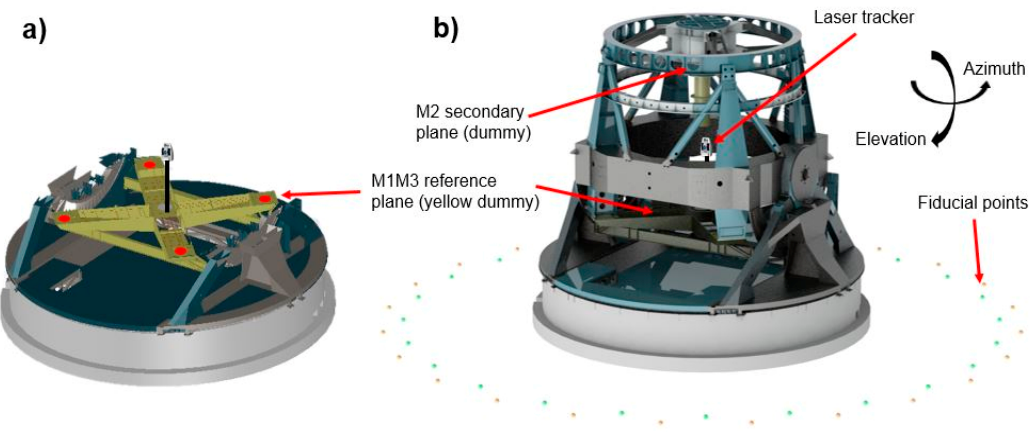
Figure 1. Measurement scenario for RPE assessment. ( a ) M1M3 measurement plane (measurement targets in red) ( b ) Complete LSST measurement scenario.